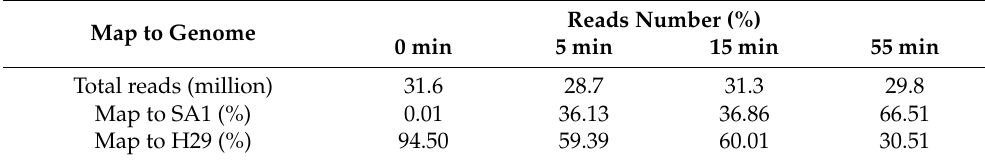
Table 1. Alignment statistics of clean reads mapped to reference genome/gene sequences. Map to Genome